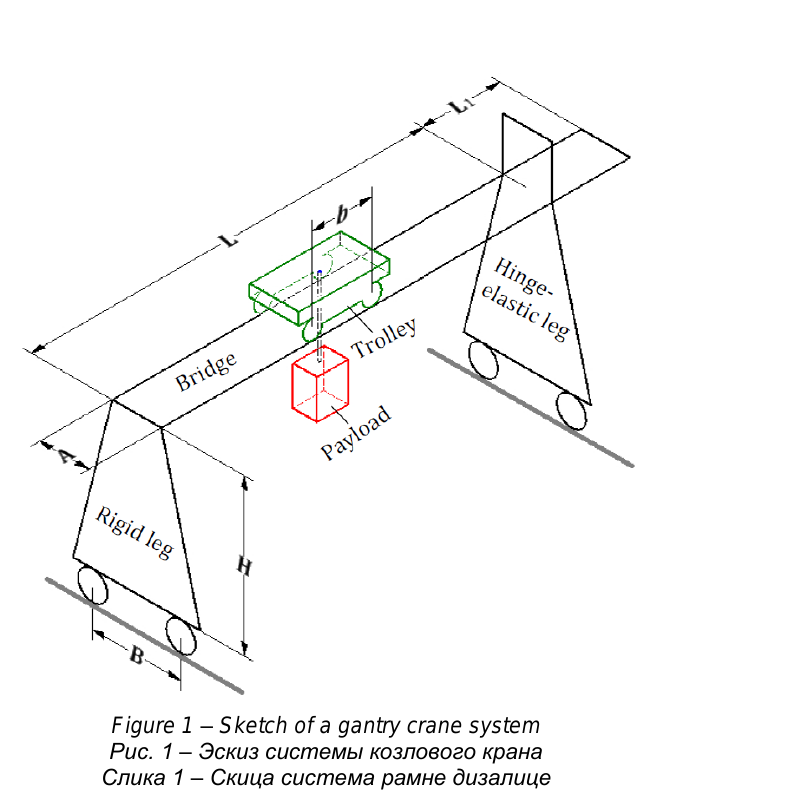
Figure 1 – Sketch of a gantry crane system Рис. 1 – Эскиз системы козлового крана